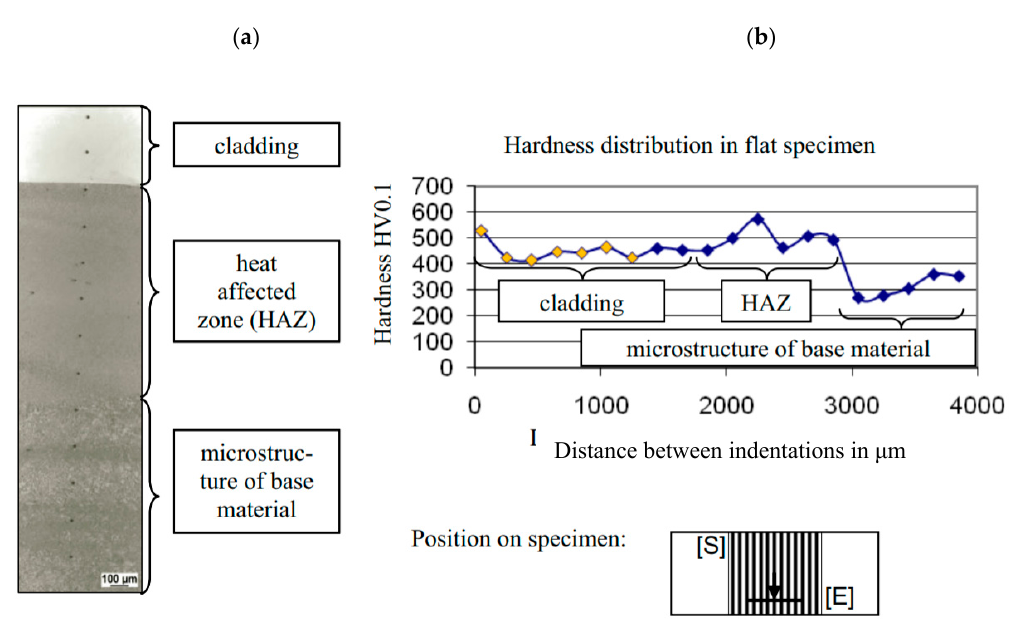
Figure 10. ( a ) Microstructure, ( b ) hardness distribution and location of both in DED flat specimen (bottom, the Starting point (S), Endpoint (E)) [86].